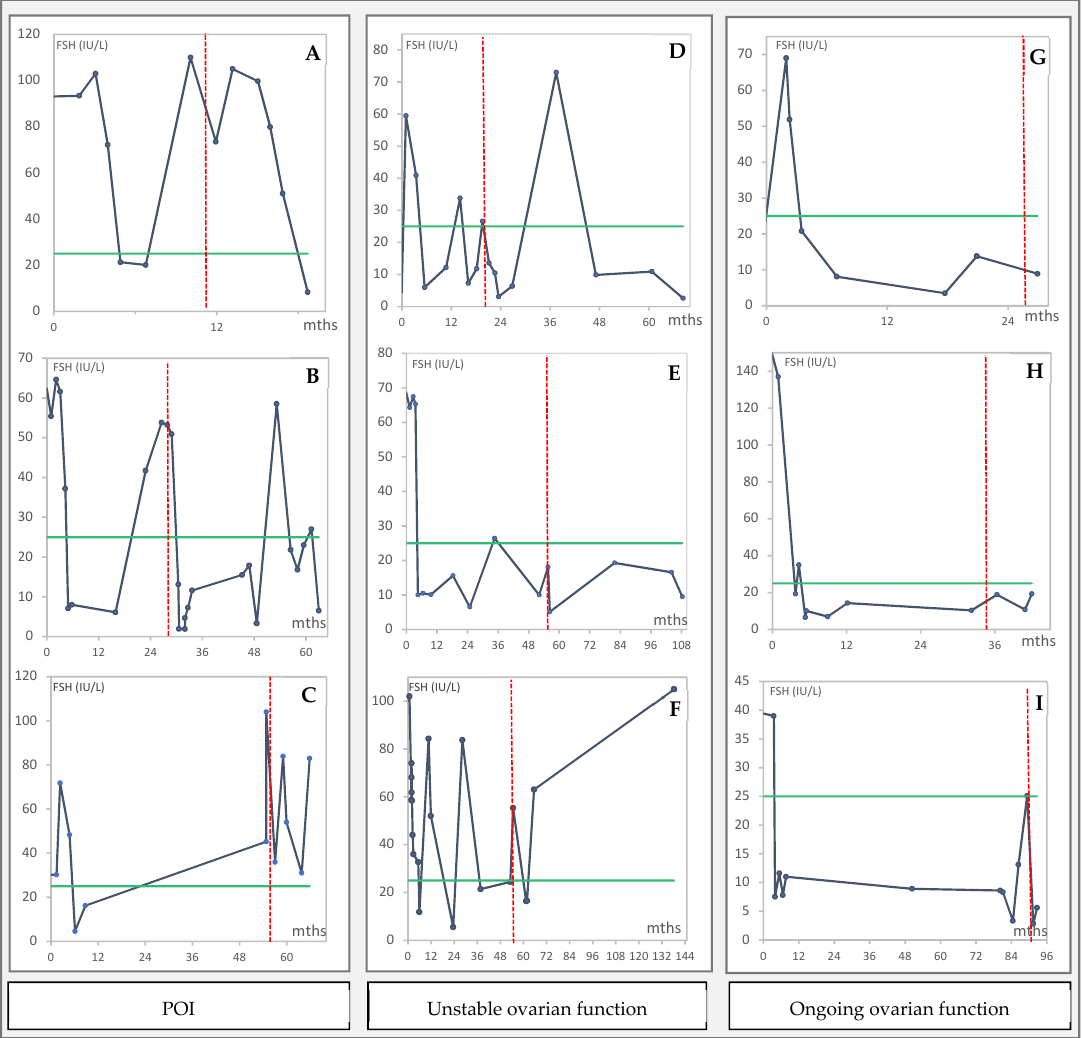
Figure 2. Fluctuation of FSH (IU/L) in months from the first OTT in the nine women with a second OTT, who had POI at the first OTT. The women (A to I) are grouped by indication for the second OTT (A-C: recurrent POI, D-F: unstable ovarian function, G-H: ongoing ovarian function). The red vertical dotted line indicates the time for the second OTT. The green horizontal line indicates the reference value for FSH=25 IU/L.